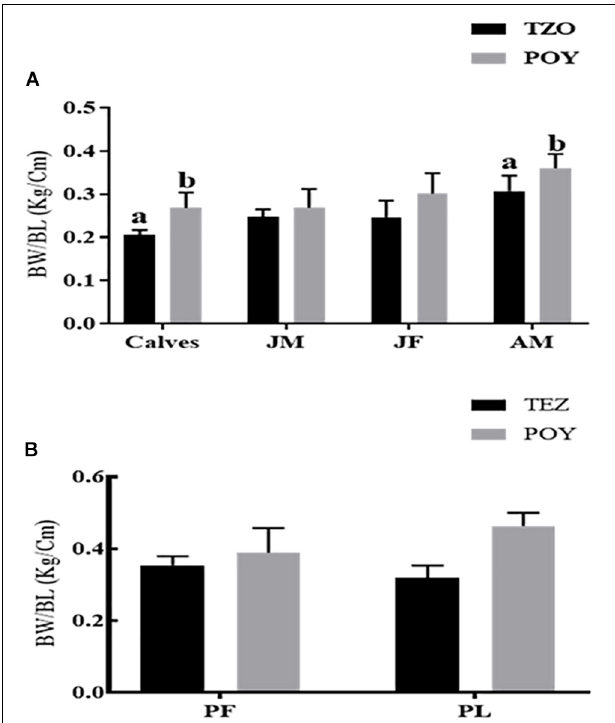
FIGURE 5 | (A) Across the age groups and (B) across the reproductive status. Overall comparison of the body-weight/body-length between the two populations. The body-weight/body-length in each group followed by an alternate letter was significantly different at P ≤ 0.05. JM, Juvenile males; JF, Juvenile females; AM, Adult males; PF, Pregnant female; PL, Pregnant plus lactating